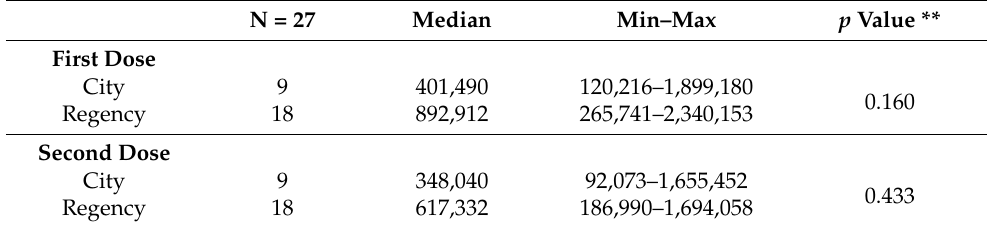
Table 2. Statistical analysis of total vaccination number based on regional status. N = 27